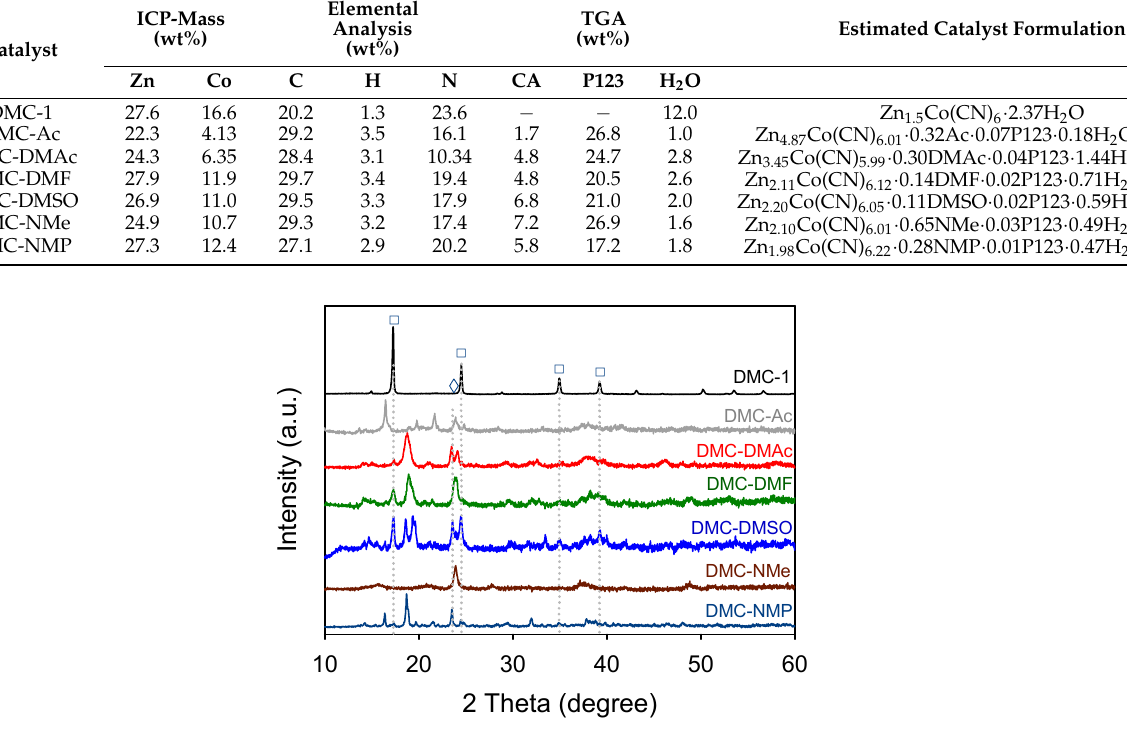
Figure 4. XRD pa tt erns of the DMC catalysts. ( □ ) and ( ◊ ) denotes the reflections corresponding to Figure 4. XRD patterns of the DMC catalysts. ( (cid:3) ) and ( ♦ ) denotes the reflections corresponding to the cubic and monoclinic phases, respectively. the cubic and monoclinic phases,